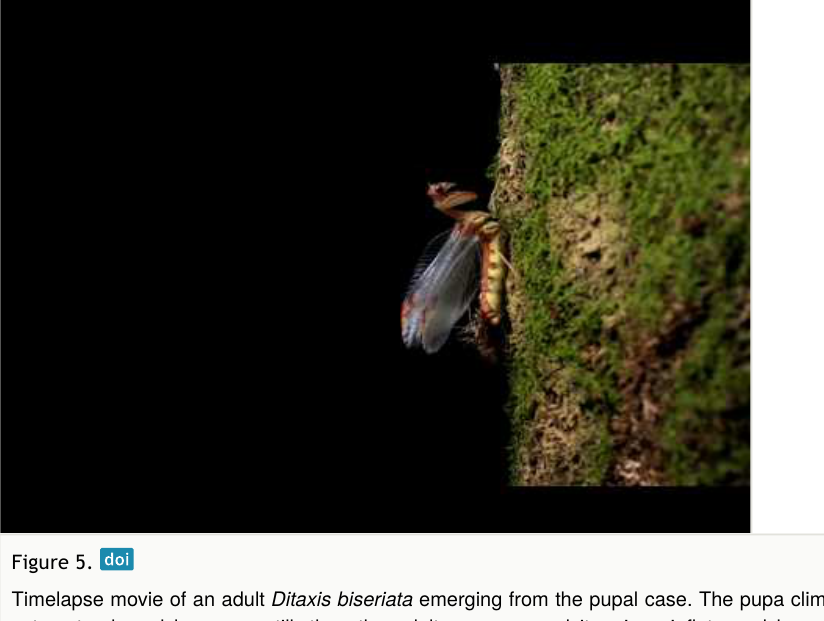
Figure 5. Timelapse movie of an adult Ditaxis biseriata emerging from the pupal case. The pupa climbs a tree trunk and becomes still, then the adult emerges and its wings in fl ate and become transparent. In real time the process shown here took 43